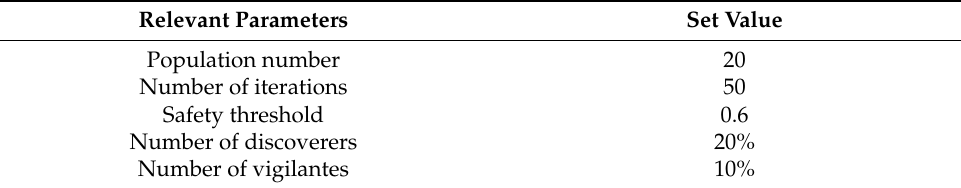
Table 3. SSA initialization parameter setting.